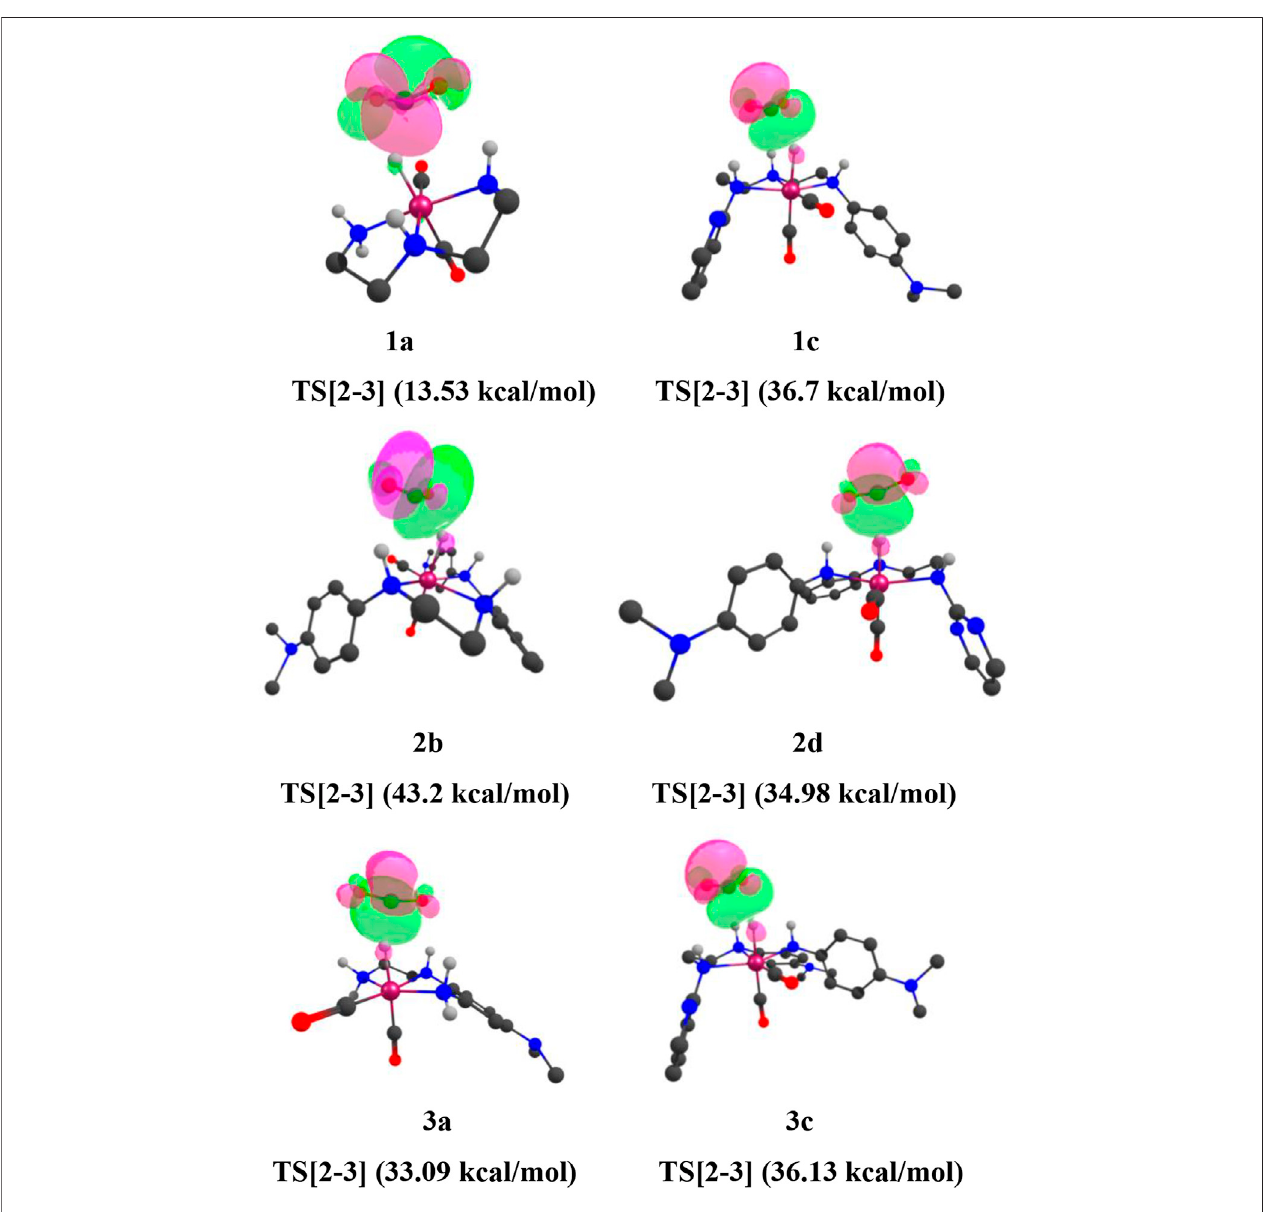
FIGURE 13 | (Mn)H — CO 2 interaction of natural bond orbitals (NBOs) of TS[2-3] of catalysts 1a, 1d, 1e, 2a, 2b, 2e , and 3a (isovalue (cid:1) 0.0174). Interaction energies are indicated in parentheses. The structures are visualized using the Chemcraft software (Chemcraft, 2021) (NBO for all catalysts are given in Supplementary Data Sheet S1